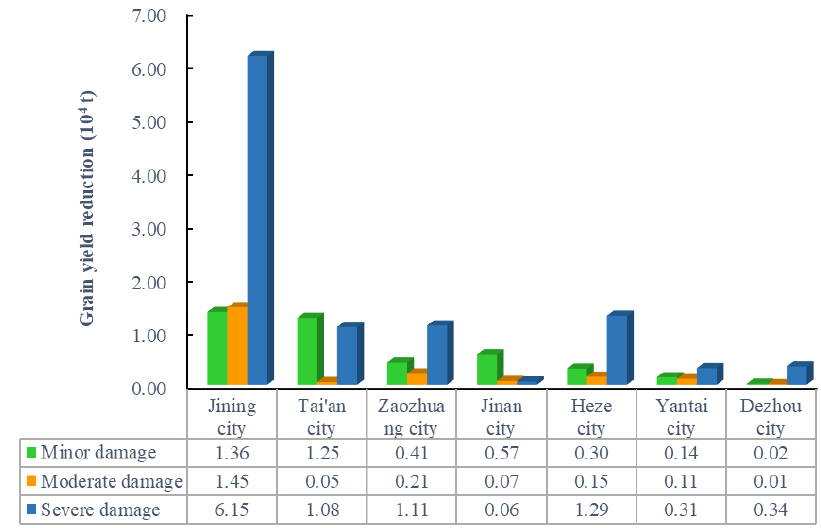
Figure 8. Grain yield reduction by 2025.